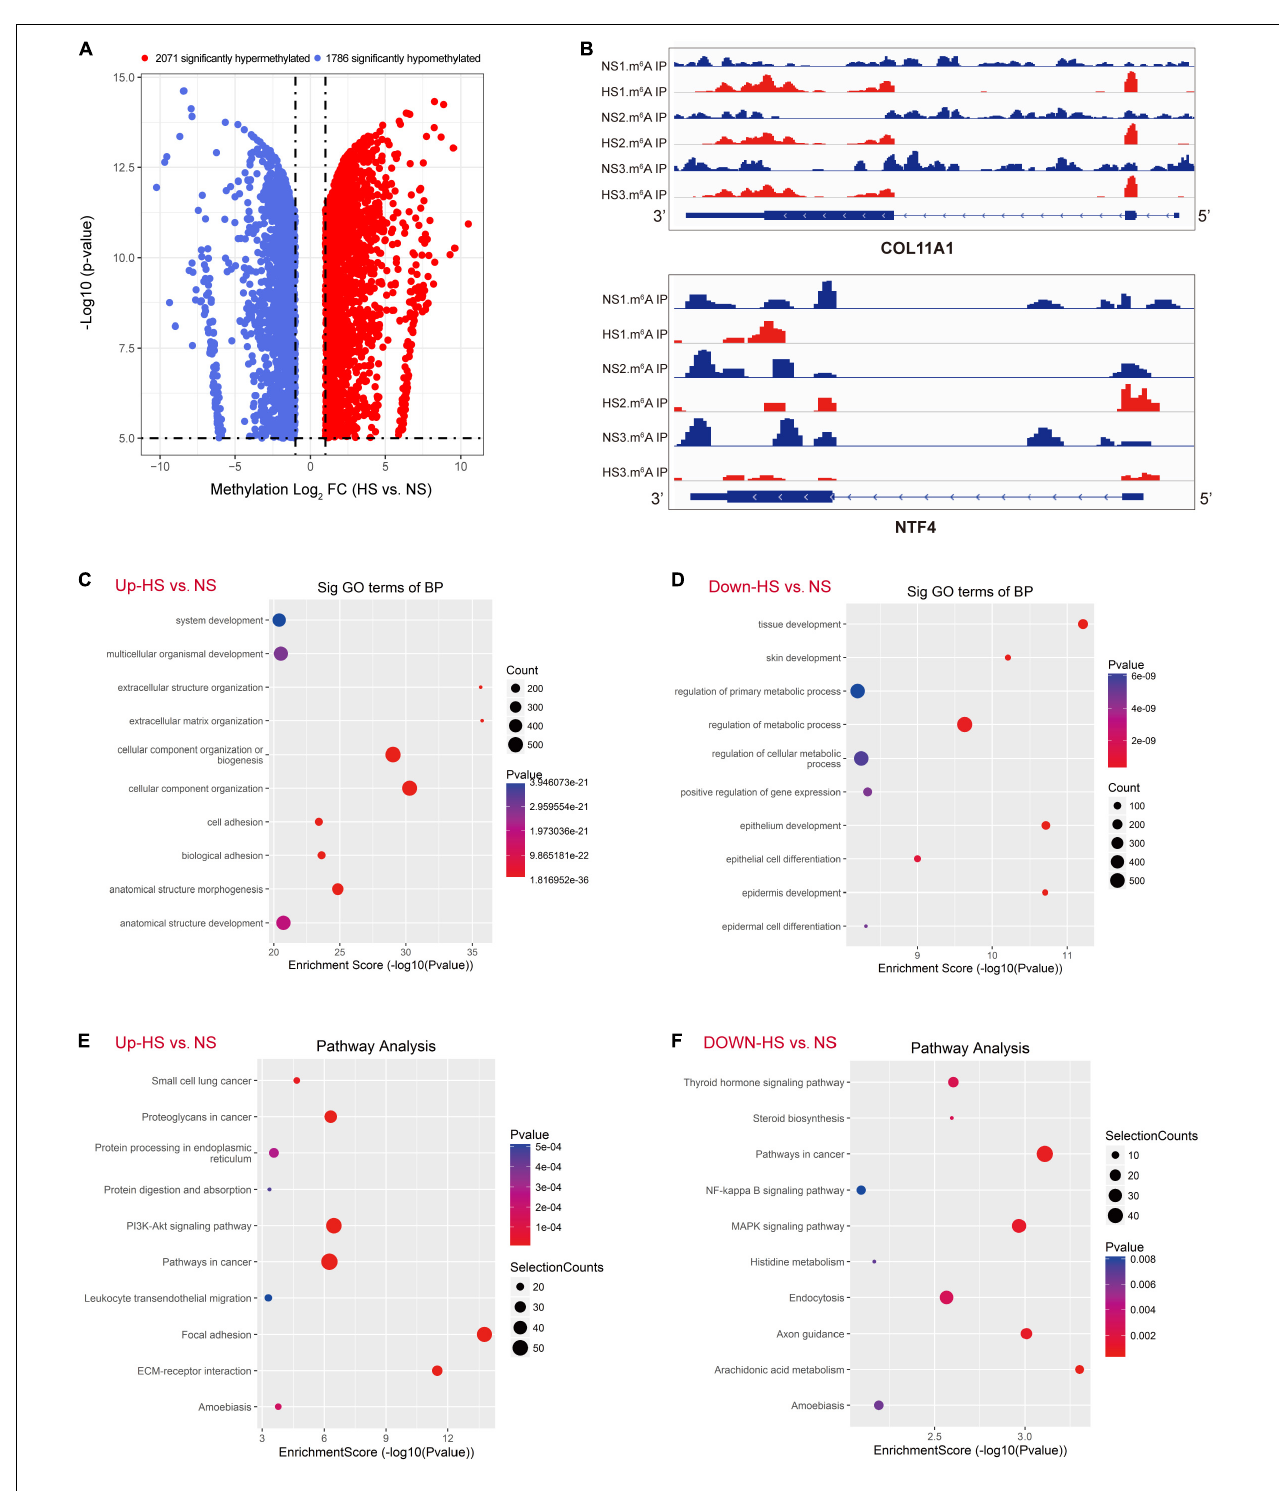
FIGURE 2 | Global m 6 A modification changes in hypertrophic scar (HS) tissues compared with normal skin (NS) tissues. (A) Volcano plots displaying the distinct m 6 A peaks (fold change > 2, p < 0.05). (B) The m 6 A abundances in COL10A1 and NTF4 transcripts in NS and HS samples, as detected by m 6 A-seq. (C) Gene ontology (GO) analysis of biological process involved in up-methylated genes in HS samples conducted by top GO. (D) GO analysis of the biological process involved in down-methylated genes in HS samples conducted by top GO. (E) Gene set enrichment pathway analysis of transcripts with increased m 6 A modification in HS samples compared with NS samples by top GO. (F) Pathway analysis of transcripts with reduced m 6 A modification in HS samples compared with NS samples. HS, hypertrophic scar group; NS, normal skin group.